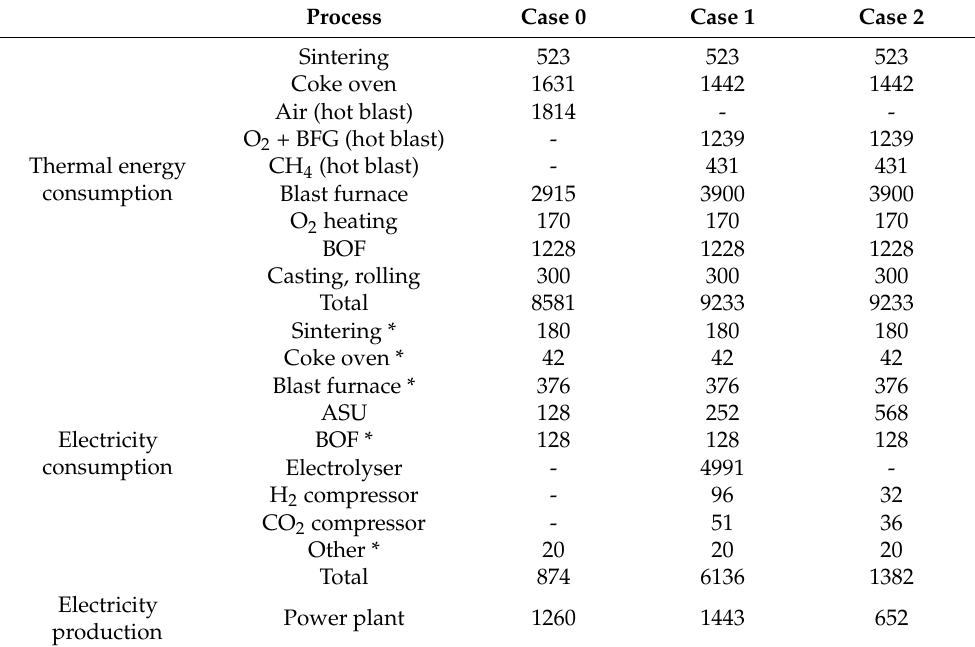
Table 3. Main energy streams (MJ/t steel) calculated for Case 0, Case 1, and Case 2. * From: [15].